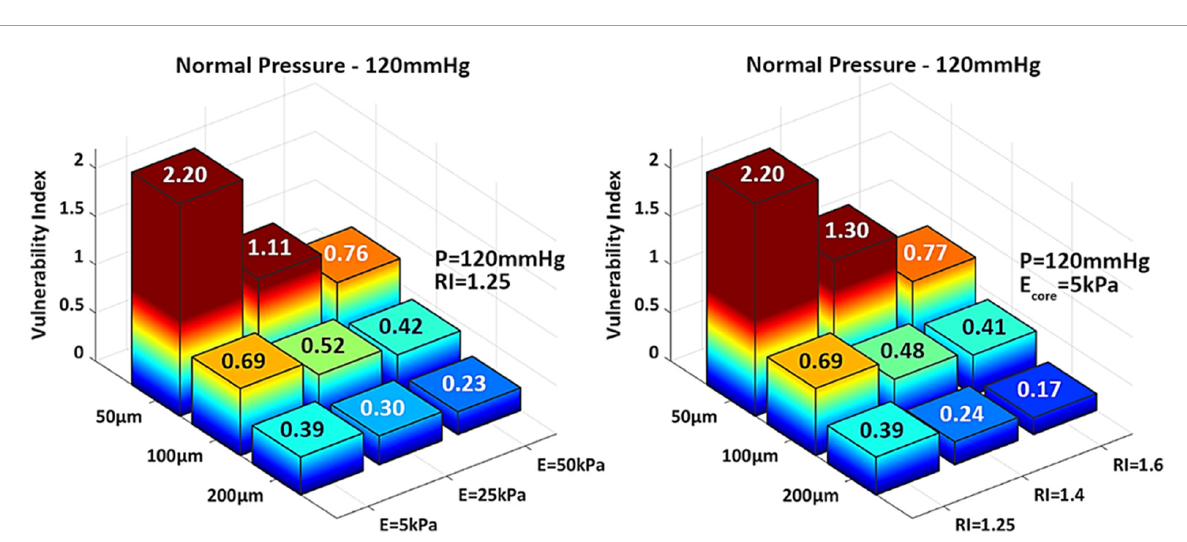
FIGURE4 3D-barplots of the change of the vulnerability index based on cap thickness, lipid core Young’s Modulus (Left) and remodeling index (Right) . The exact VI value is reported on top of every